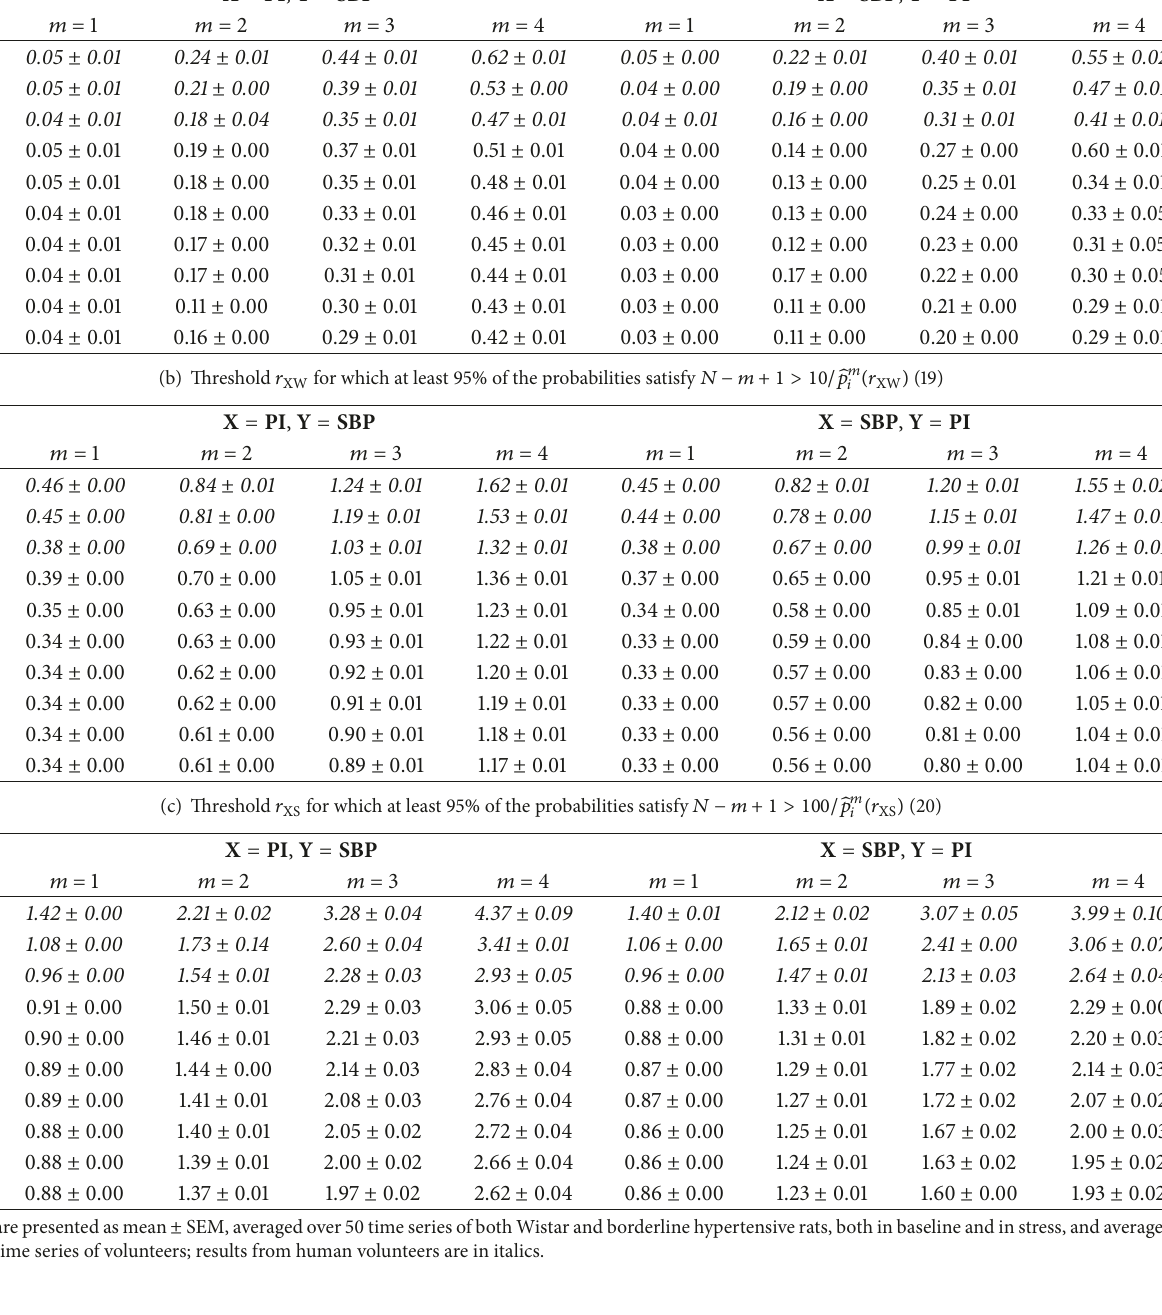
Table 5: Level of asymmetry of real signals